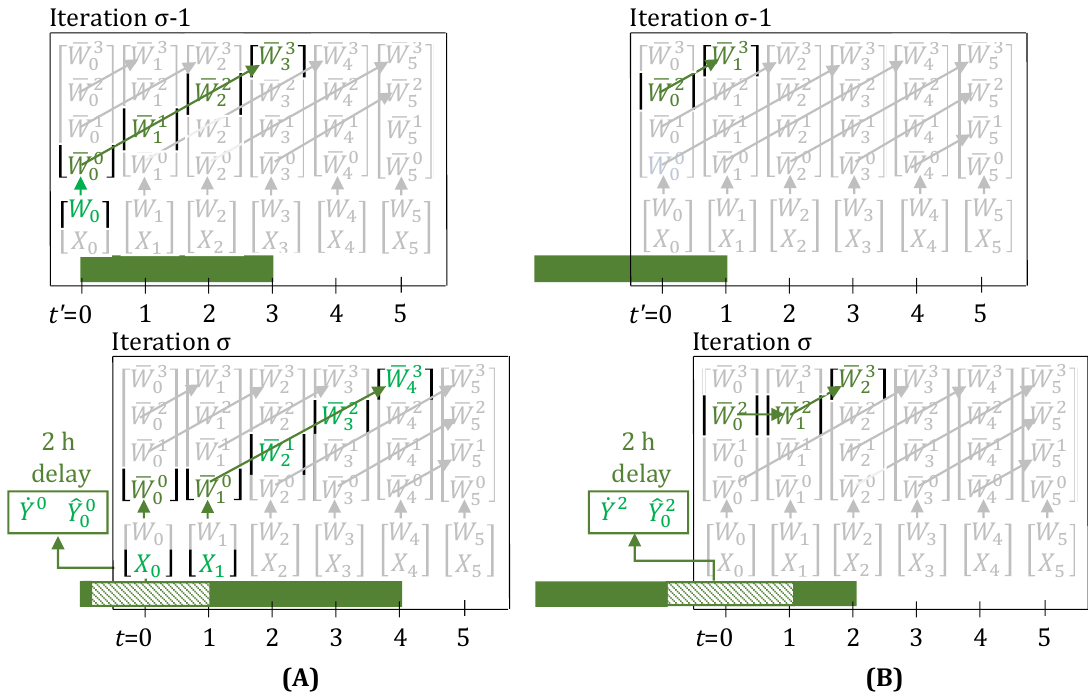
Figure 4. When a 2 h delay is observed, through the lifting equations, ¯ W n trajectory, leading to the task correctly finishing 2 h late in iteration σ . Here, τ for the task is 3. Arrows show which variables are enforced as equal by the lifting equations (Equations